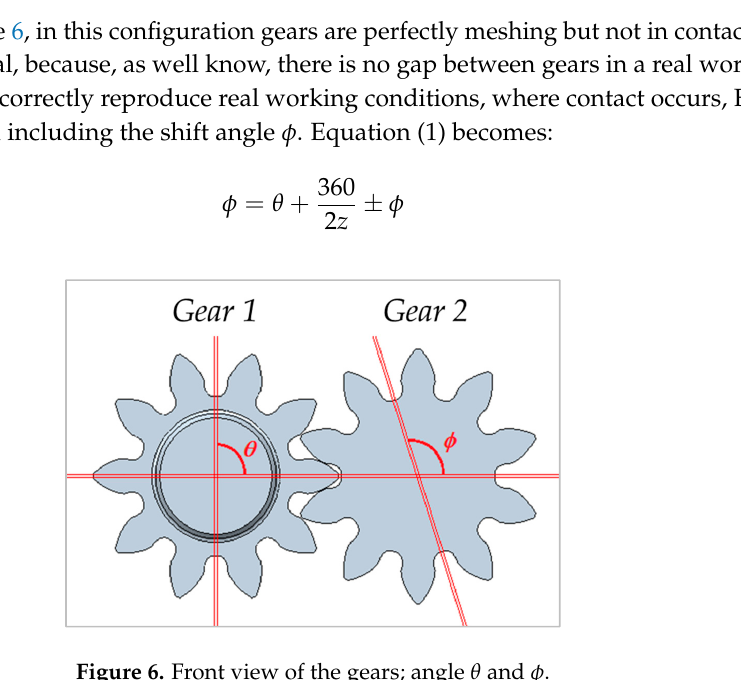
Figure 6. Front view of the gears; angle θ and φ .